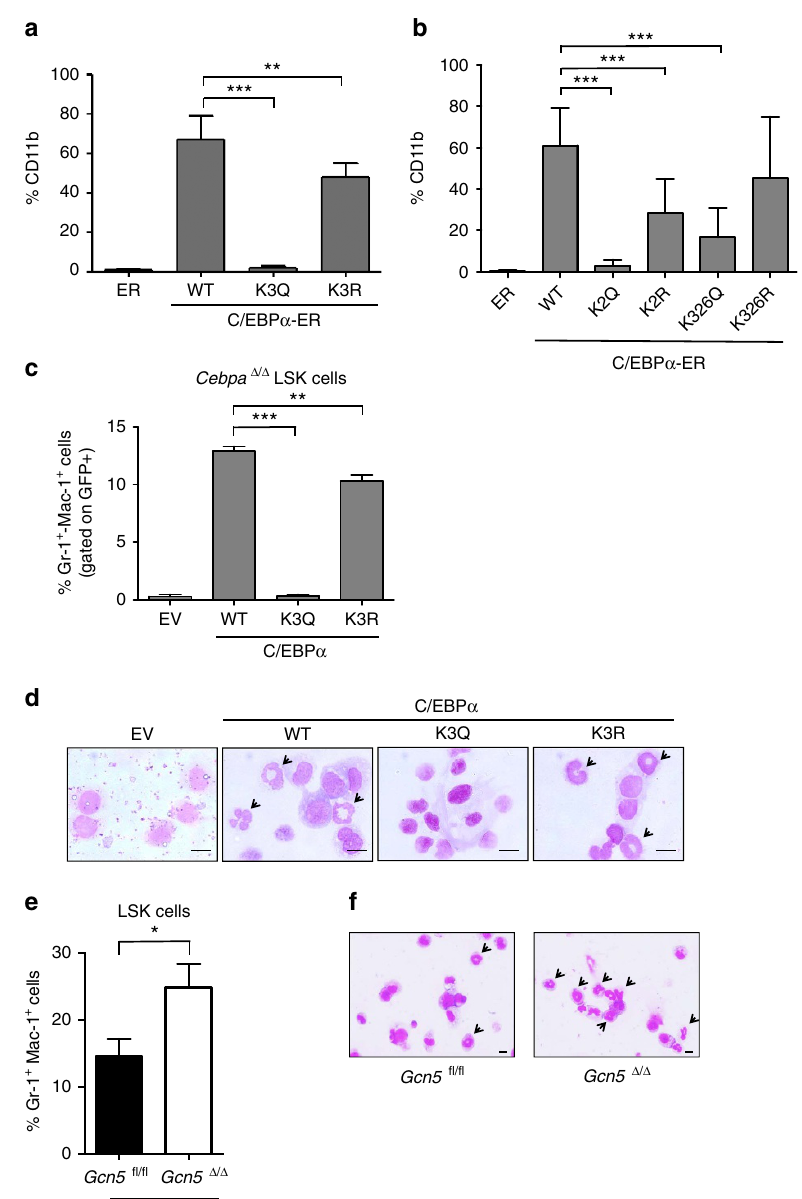
Figure 4 | Loss of differentiation potential in acetylation mimetic mutations of C/EBP a . ( a , b ) C/EBP a K3Q-ER and C/EBP a K2Q-ER fail to upregulate differentiation marker CD11b in K562 cells. K562 cells were stably transfected with EV-ER, C/EBP a WT-ER, K3Q-ER, K3R-ER, K2R-ER, K2Q-ER, K326R-ER, or K326Q-ER. Induction of C/EBP a nuclear localization was performed with addition of 5 m M b -estradiol. Cells were analysed with FACS for surface marker CD11b following 4 days of culture. Bar graph shows the percentage of CD11b þ cells, which is indicative of granulocytic differentiation. Data are mean ± s.d. from two independent clones for each construct. *** P o 0.001; Student’s unpaired t -test N ¼ 6 ( a ) and N ¼ 9 ( b ). ( c ) C/EBP a -K3Q fails to differentiate hematopoietic early progenitor cells. Lin (cid:2) Sca-1 þ c-Kit þ (LSK) cells from bone marrow of Cebpa D / D mice were transduced with retroviral expression vectors pMIG EV, C/EBP a -WT, C/EBP a -K3R, and C/EBP a -K3Q to induce differentiation into granulocytes. Cells gated on the GFP þ fraction were analysed on day 7 for surface markers Gr-1 and Mac-1, indicative of granulocytic differentiation. Data are mean ± s.d. *** P o 0.001; Student’s unpaired t -test N ¼ 3. ( d ) Lack of mature granulocytes in C/EBP a -K3Q transduced LSK cells. Cytospins were stained with Wright-Giemsa. Original magnification x100, scale bars indicate 10 m m. The arrows indicate granulocytes with their polymorphonuclear morphology. ( e ) Increase in myeloid cells on deletion of Gcn5 . LSK cells from Gcn5 D / D Vav-iCre þ and control ( Gcn5 fl/fl ) mice were cultured in G-CSF supplemented media. After 7 days, viable cells were assessed for relative expression of Gr-1 and Mac-1 using flow cytometry. Data shown are representative from four independent experiments done in triplicate. Data are mean ± s.d. * P o 0.05; Student’s unpaired t -test. ( f ) Mature granulocytes morphology from G-CSF induced in vitro culture. Cells were subjected to Wright-Giemsa staining and pictures were acquired at an original magnification (cid:3) 40. Scale bars indicate 10 m m. The arrows indicate granulocytes with their polymorphonuclear